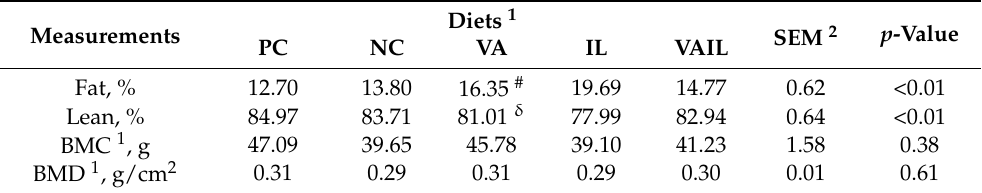
Table 3. Dual-energy X-ray absorptiometry (DEXA) scan of nursery pigs’ leg fed with very low- protein diets supplemented with isoleucine at NRC and valine above NRC levels, or a combination of the